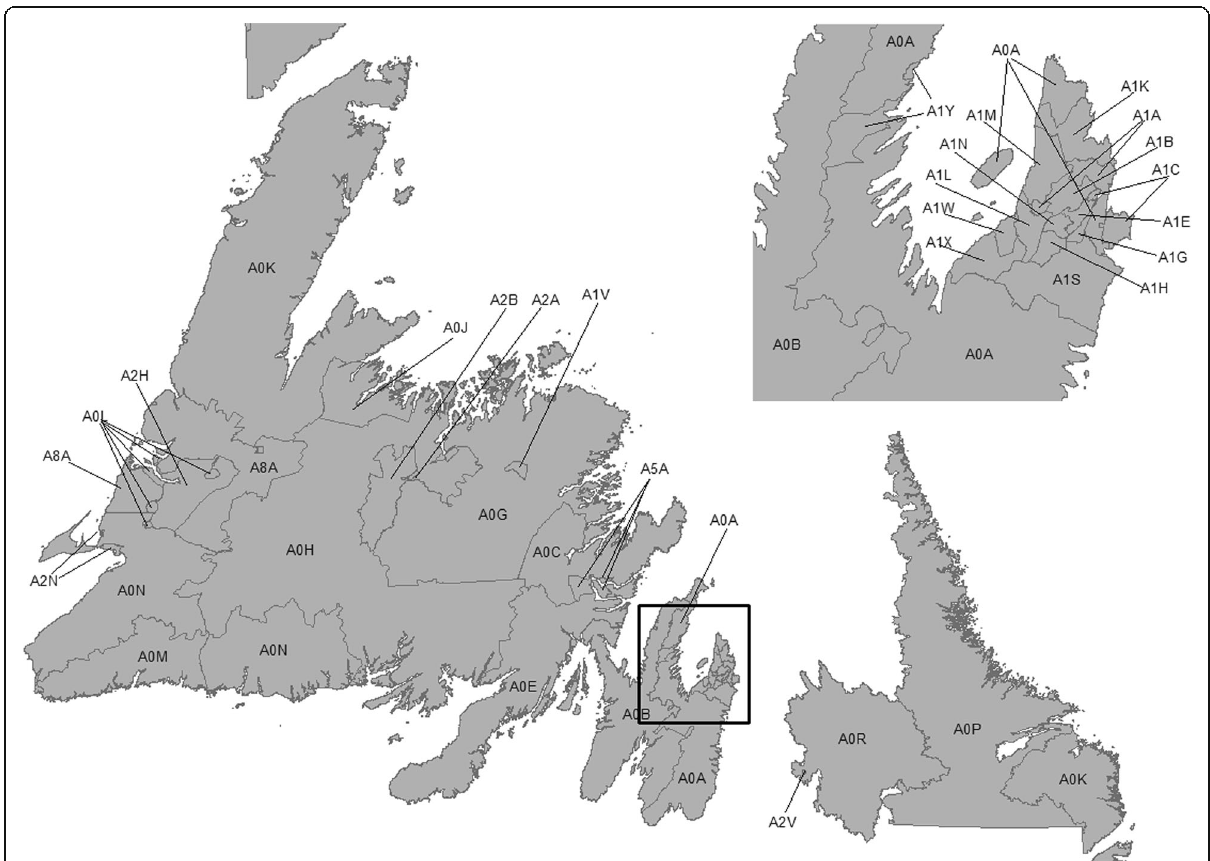
Fig. 1 FSA codes in Newfoundland and Labrador. The square represents the region included in the study, where the majority of NL ’ s population